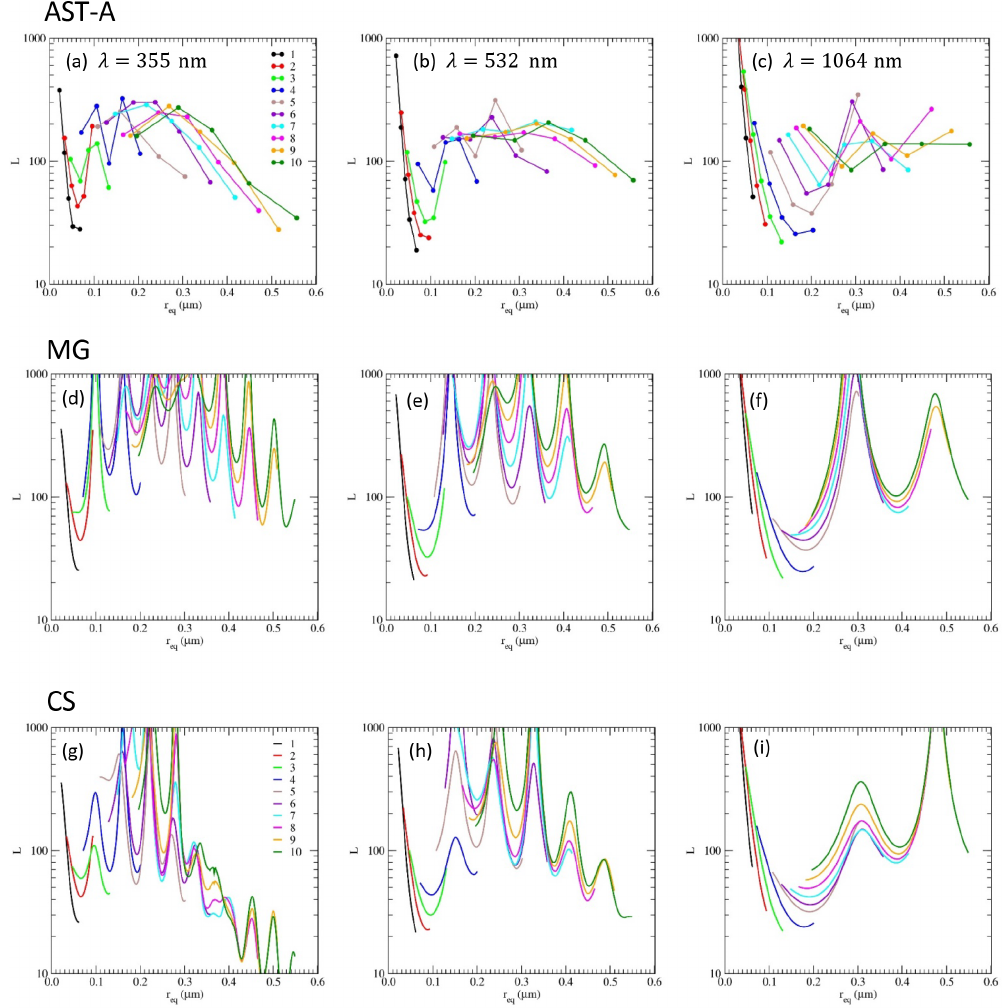
Figure 8. Results of the lidar ratio L for particles derived from the AST-A model at wavelengths of (a) 355, (b) 532 and (c) 1064nm. Panels (d) – (f) are the same as (a) – (c) , but for spheres with an average refractive index calculated using the Maxwell-Garnett mixing rule (MG). Panels (g) – (i) are the same as (a) – (c) , but for core-shell (CS) spheres. Colors and volume ratios V r for each point are the same as those in Fig. 6a for the AST-A model ( V r ∼ 0251020 from left to right for circles of the same color). For (d) – (i) , calculations were performed for V r ≤ 20 with a step size of